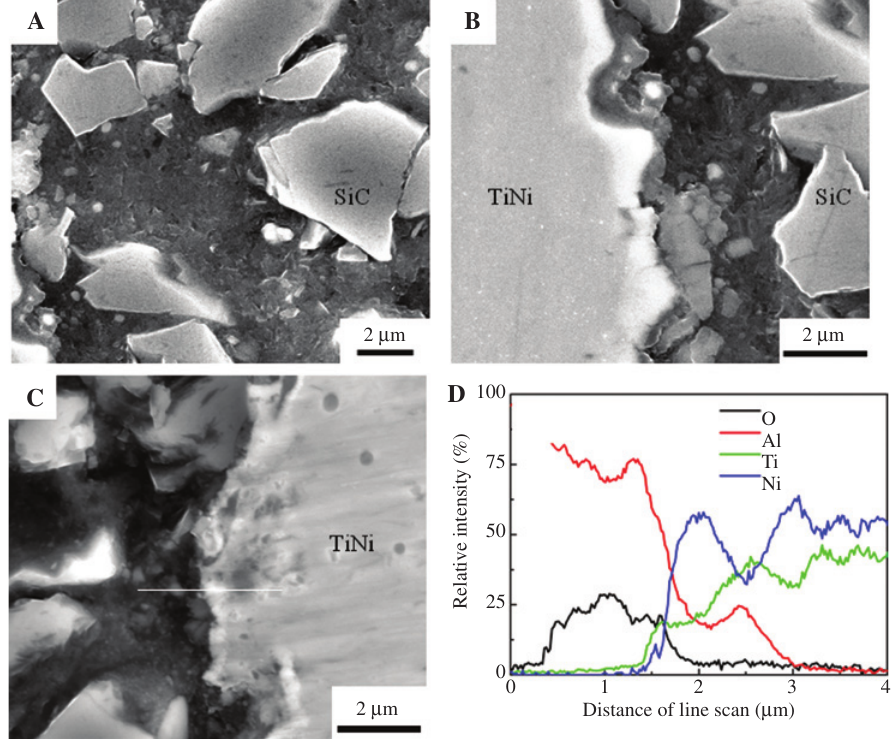
+TiNi /Al composite: (A) interface between SiC and Al, (B) interface between TiNi and p f